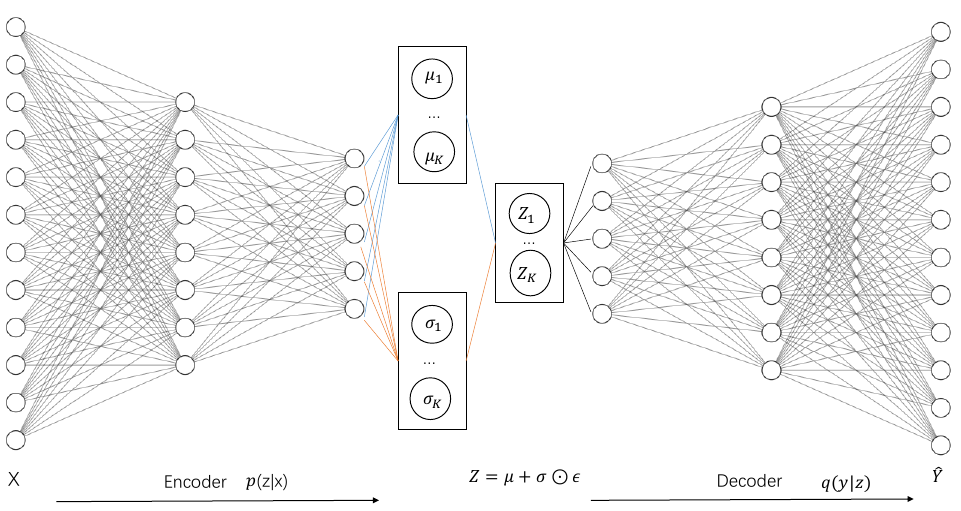
Figure 1. The network structure of DeepVIB. The encoder p ( z | x ) learns a representation Z from X , in which the reparameterization trick z i = µ i + σ i (cid:12) (cid:101) is implemented, and (cid:12) means the element-wise product. The decoder q ( y | z ) uses Z to predict Y